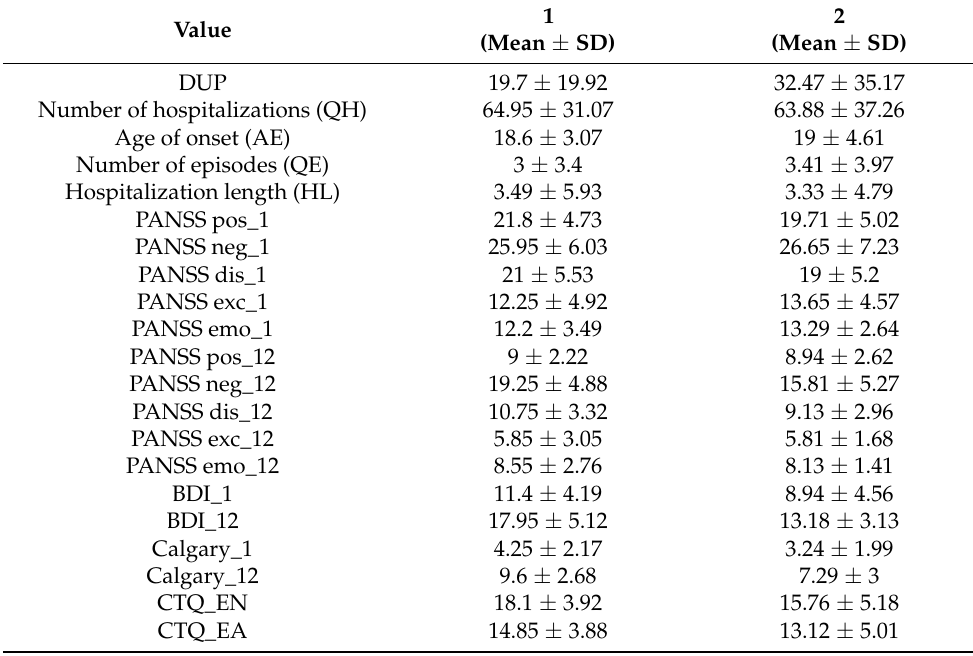
Table 6. Descriptive statistics on the analyzed variables in separate groups of